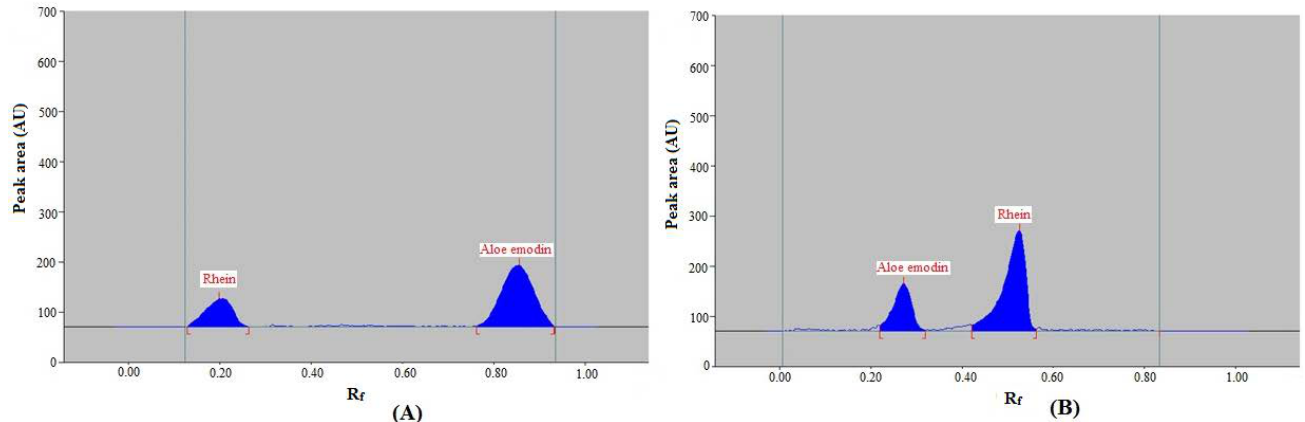
Figure 2. Representative high-performance thin-layer chromatography (HPTLC) densitograms of standard rhein and aloe-emodin obtained using ( A ) sustainable reverse-phase HPTLC and ( B ) con- ventional normal-phase HPTLC